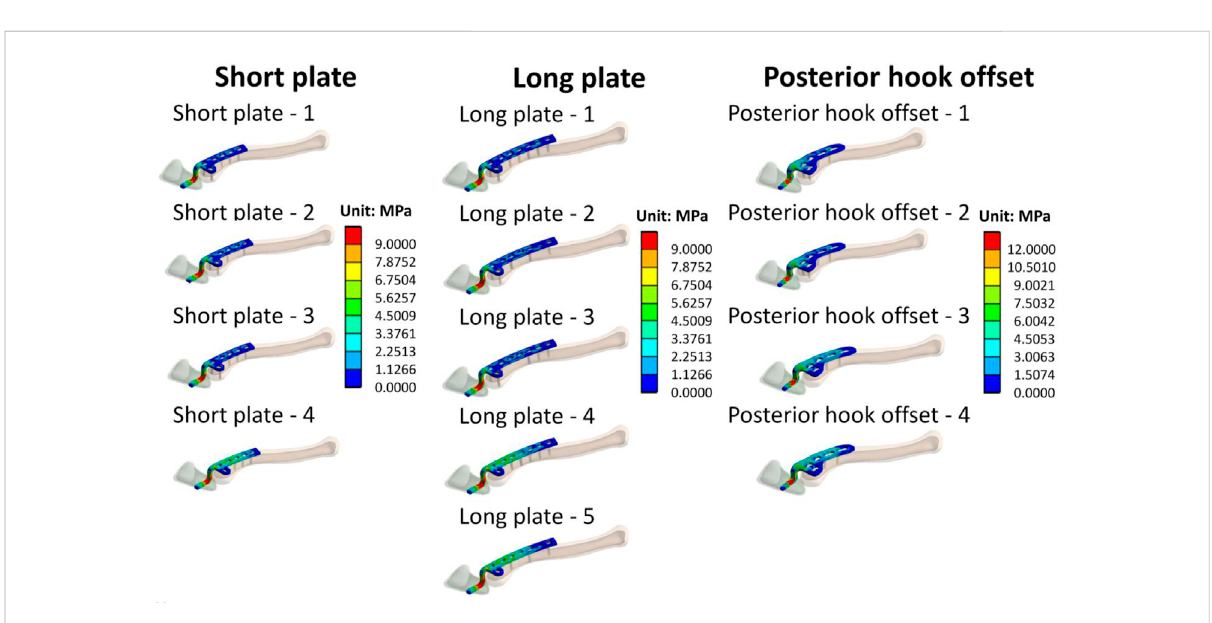
FIGURE 7 Stress distribution on clavicle hook